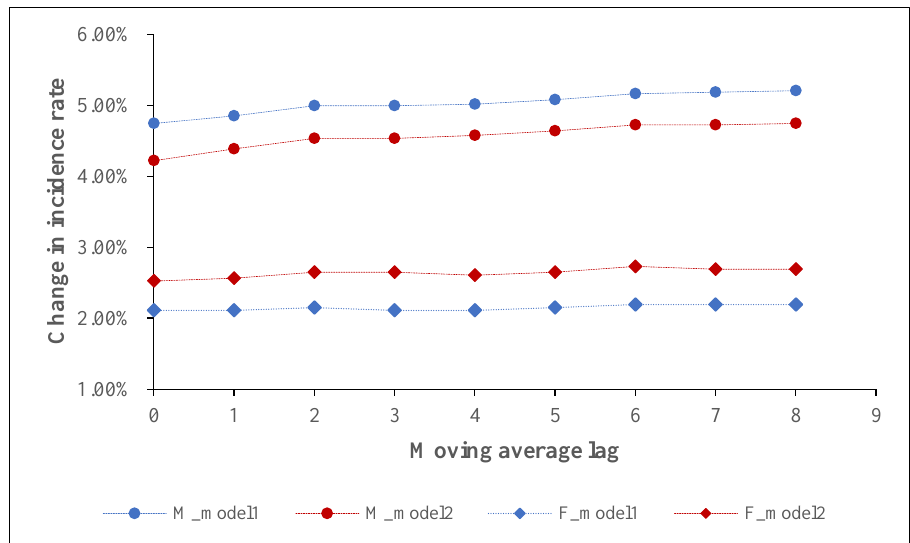
Figure 4. Association between PM2.5 and the incidence rates of lung cancer using different moving average year lags.